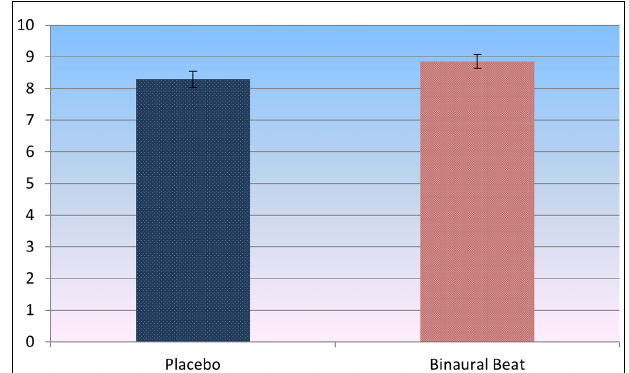
FIGURE 5 | Self-report ratings of perceived relaxation post-treatment ( t = 2.248, p = 0.036, d = 0.493). Error bars represent ± 1 SE of the marginal